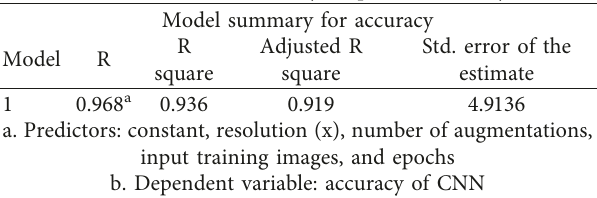
Table 3: Model summary output for accuracy.